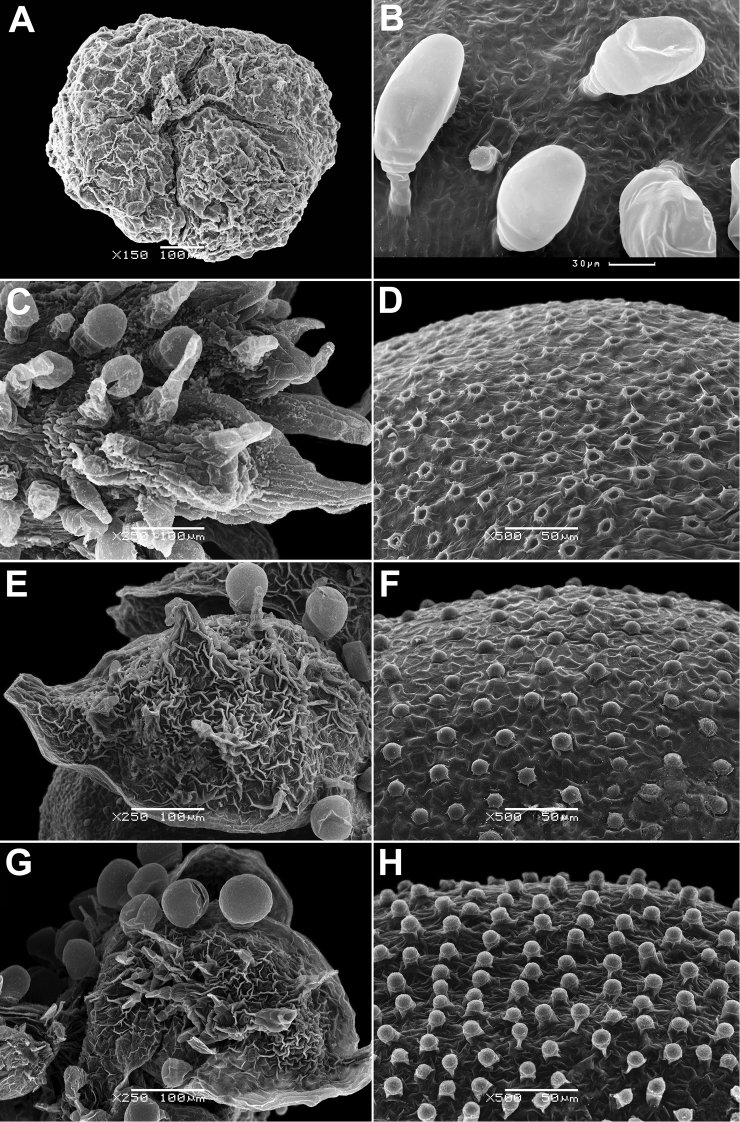
SEM micrographs: A perianth of DysphaniaambrosioidesB pericarp of DysphaniaambrosioidesC perianth of D.himalaicaD pericarp of D.himalaicaE perianth of D.bhutanicaF pericarp of D.bhutanicaG perianth of D.kitiaeH pericarp of D.kitiae. Magnification: 150× (A), 250× (C, E, G), 500× (B, D, F, H).